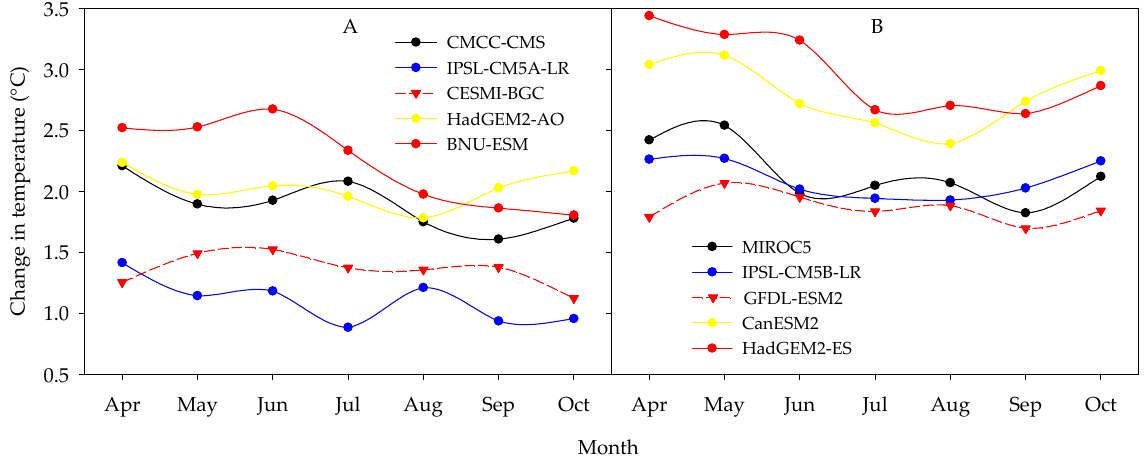
Figure 6. Projected changes in monthly temperature for 5 general circulation models under two representative concentration pathways ( A is RCP 4.5 and B is RCP 8.5) for the period 2040–2069. Annual rainfall over the 30-year period ranged from 695 to 1580 mm, with an average of 1062 mm. Percentage change in the amount of rainfall ranged from − 3.97% to 2.17% under RCP 4.5 and − 7.21% to 9.51% for RCP 8.5 (Figure